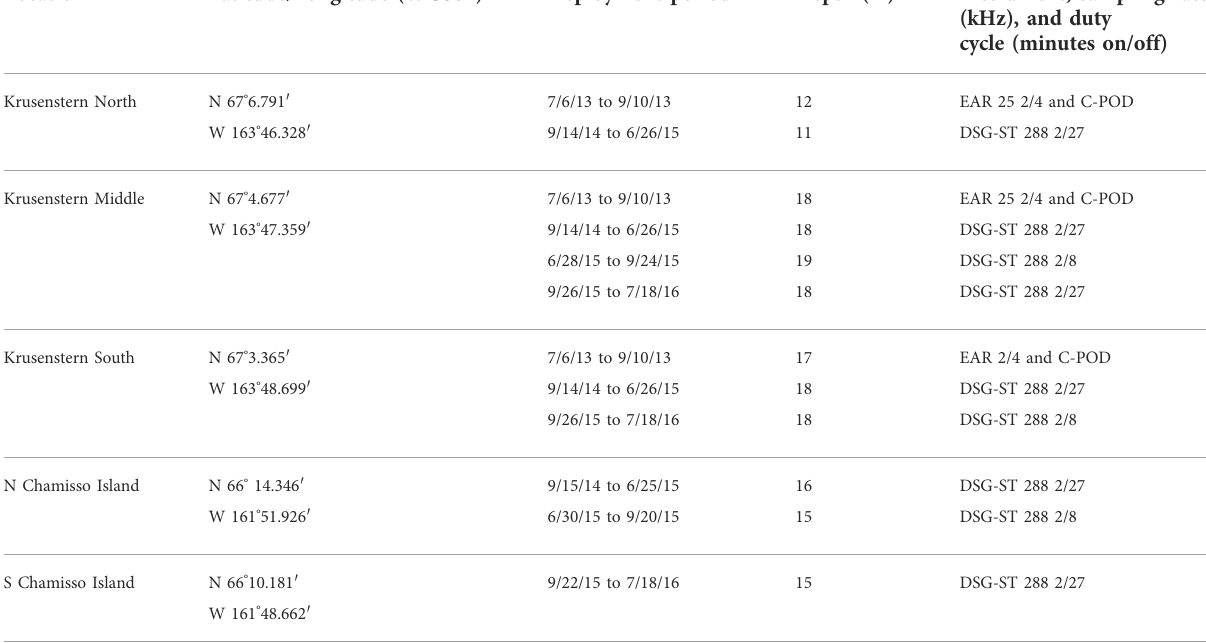
TABLE 1 Deployment details for the four locations in Kotzebue Sound, Alaska, acoustically monitored from 2013 to 2016 for cetacean